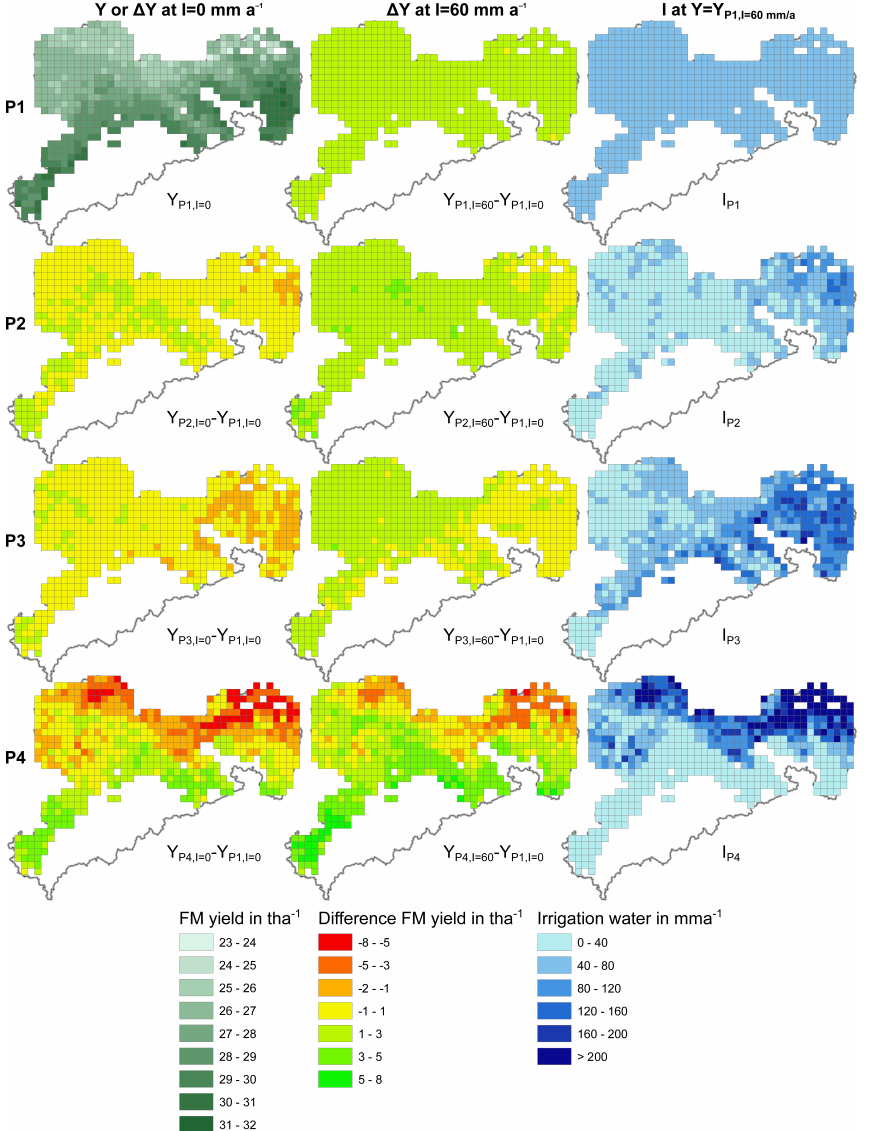
Figure 3. 1st column: regional fresh matter bean yield (1st row) and yield differences between future time periods (2nd to 4th row) with no irrigation. 2nd column: fresh matter yield differences for each time period from no irrigation to 60mm per year irrigation. 3rd column: irrigated water amount, if crop yield shall not decrease under yield level of period P1. All results are averaged over all soils in each grid cell and medians of corresponding SCWPF (for details see Wagner et al.,